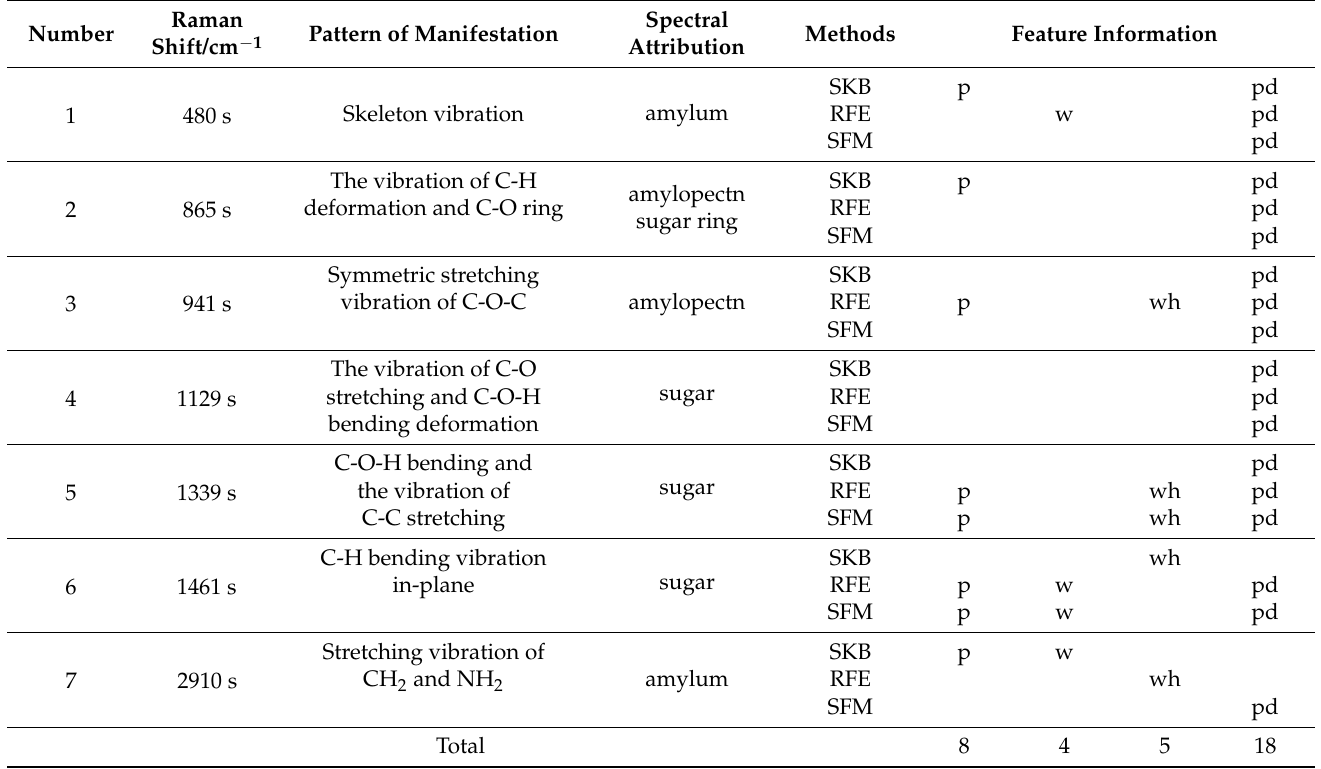
Table 5. Features and attribution of rice Raman spectra (s: strong; p: prominences; w: width; wh: width_height; pd: